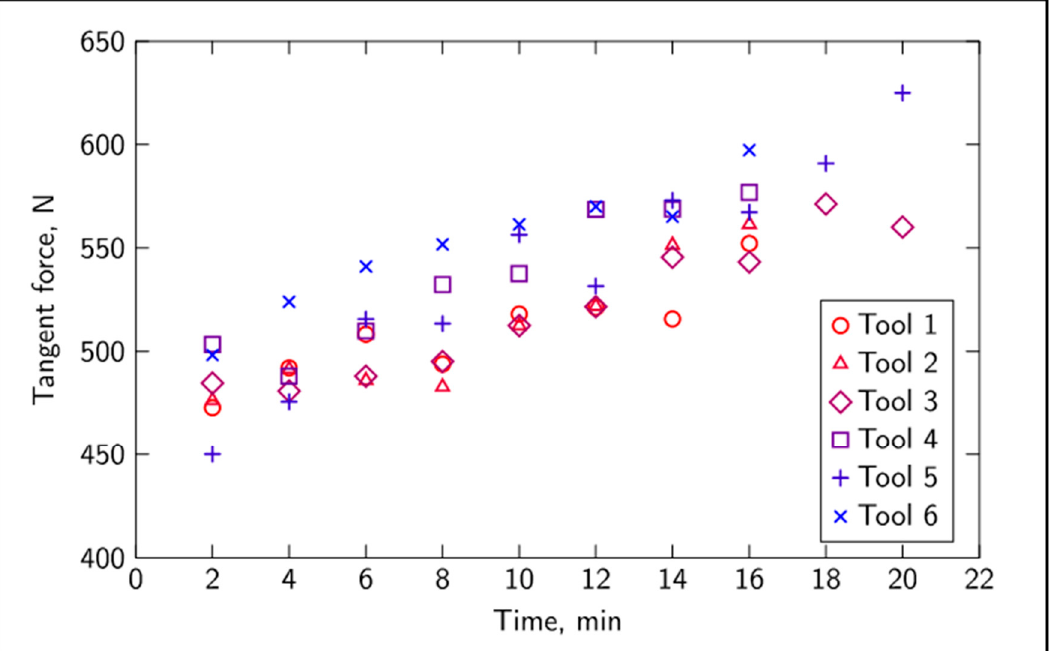
Sensors 2020 , 20 , x FOR PEER REVIEW Figure 4. Tangential force evolution over time for all tools. Figure 4. Tangential force evolution over time for all tools.